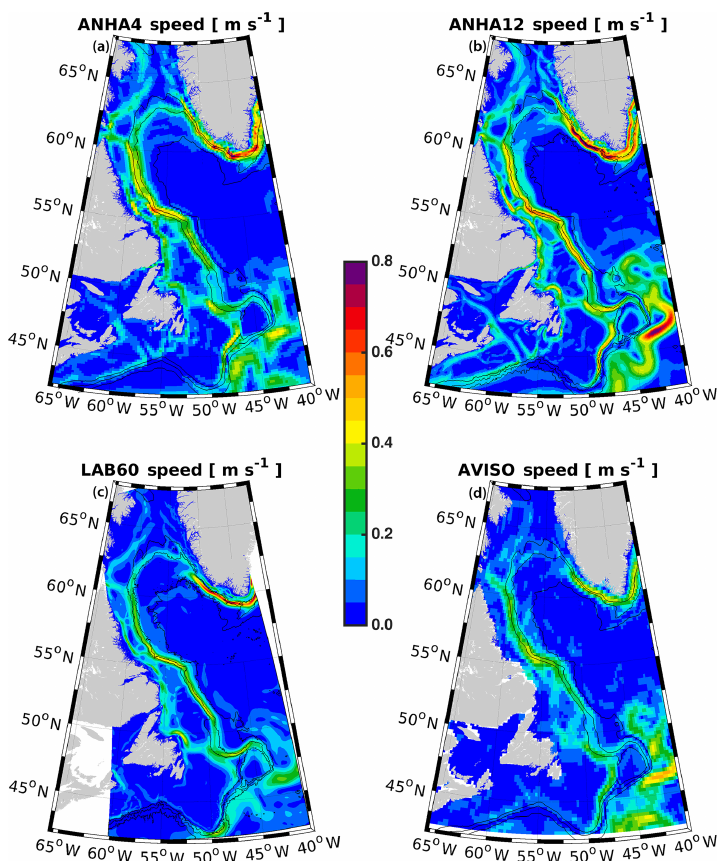
Figure 4. Top 50m average speed (2004–2013) for (a) ANHA4, (b) ANHA12, (c) LAB60, and (d) from AVISO observations. The 1000, 2000, and 3000m isobaths are shown by the black contour